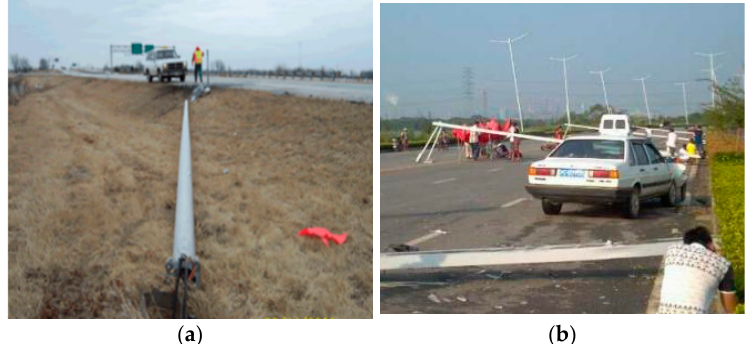
Figure 1. Wind-induced vibration collapse accident of high-mast light poles. ( a ) Light pole collapse accident in western Illinois. ( b ) Light pole collapse accident in Nanchang City.